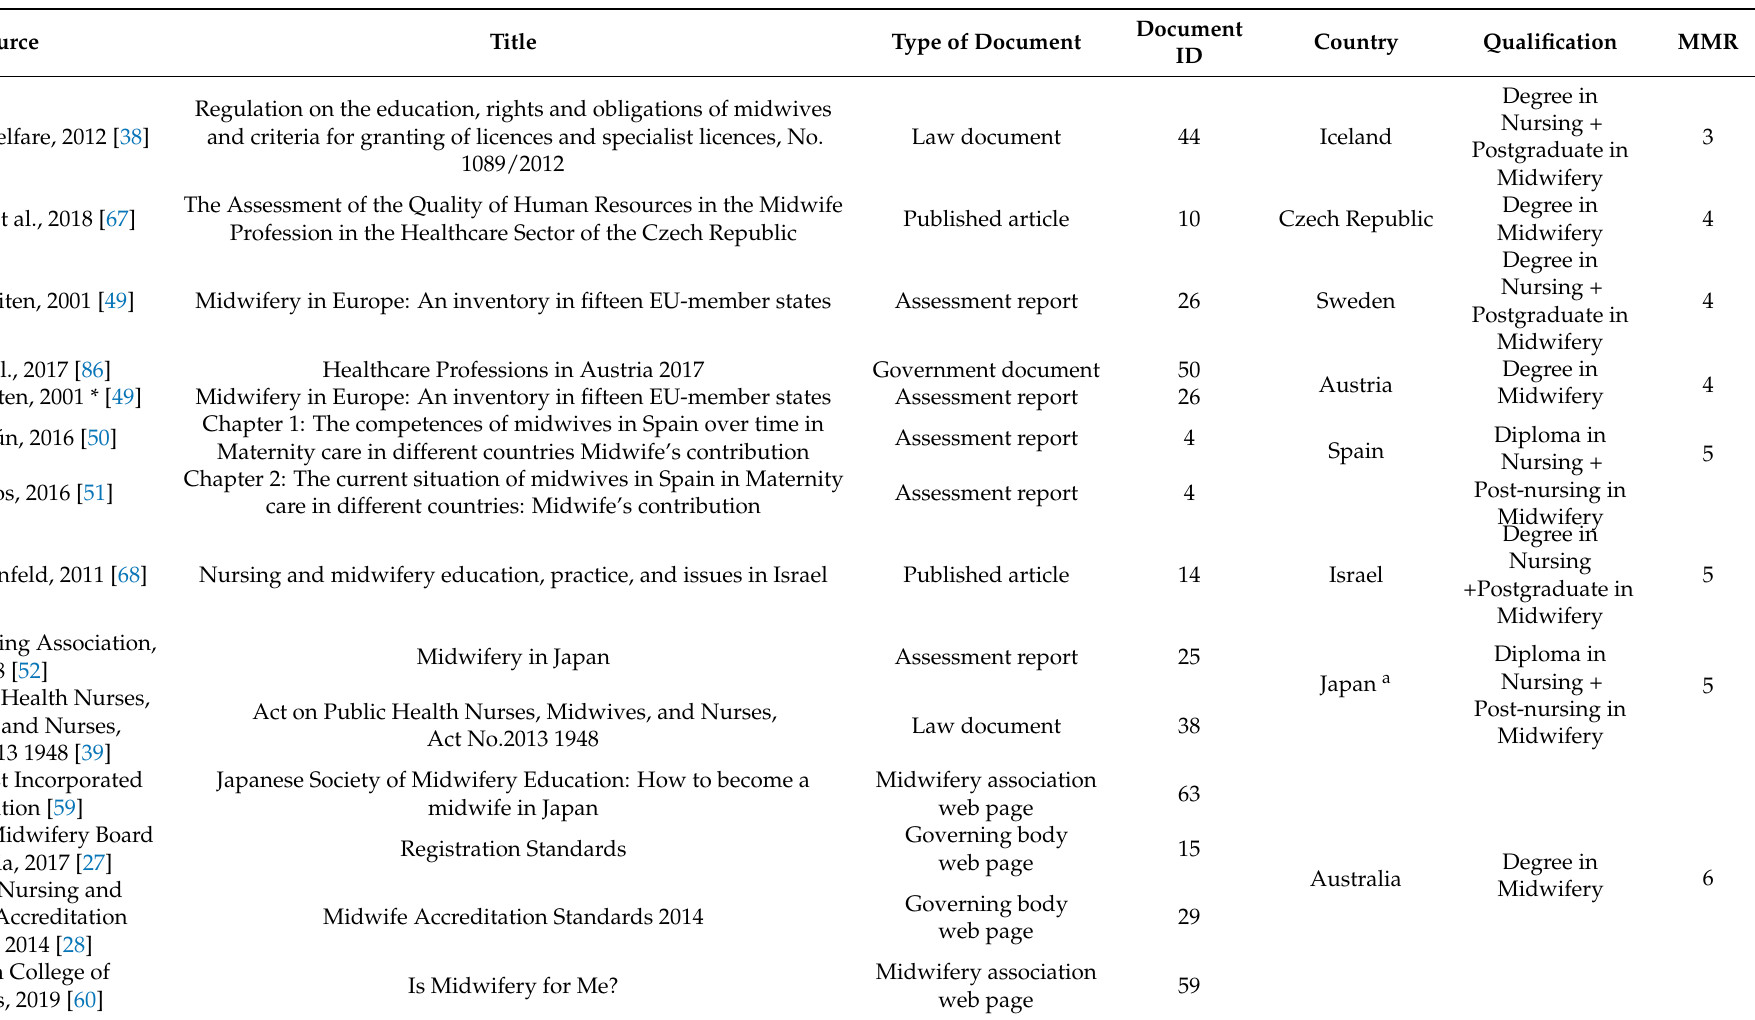
Table 1. Minimum qualification required to practise as a recognised